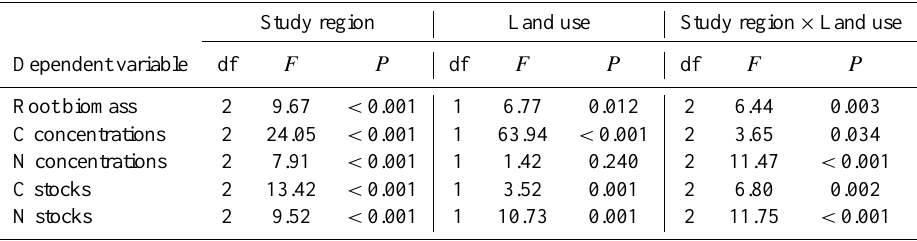
Table 3. ANOVA results of fine root biomass, C and N concentrations and stocks, to compare variance between study regions and differences between grasslands and forests (defined here as land use).